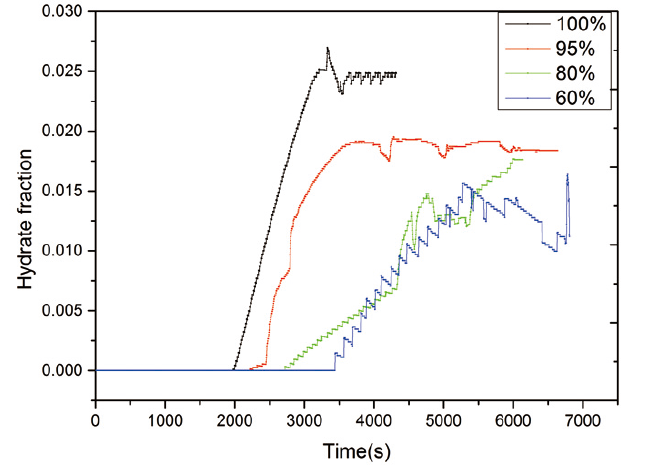
Figure 5. Curve of hydrate volume fraction with time at different water cuts